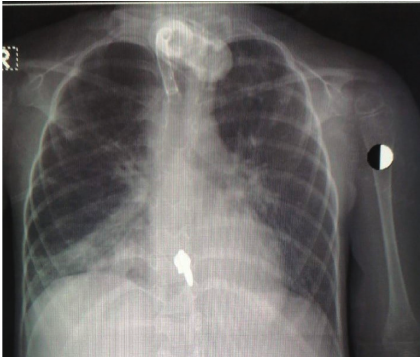
Figure 2: Onset of COVID-19: similar findings as in Figure 1 with exaggerated bronchovascular